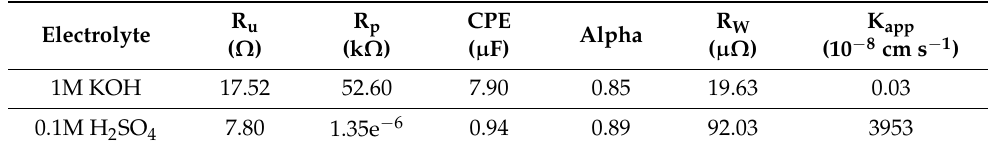
Table 2. Electrochemical parameters estimated from EIS analysis Ti 3 C 2 T x /Ag 2 CrO 4 modified electrode.